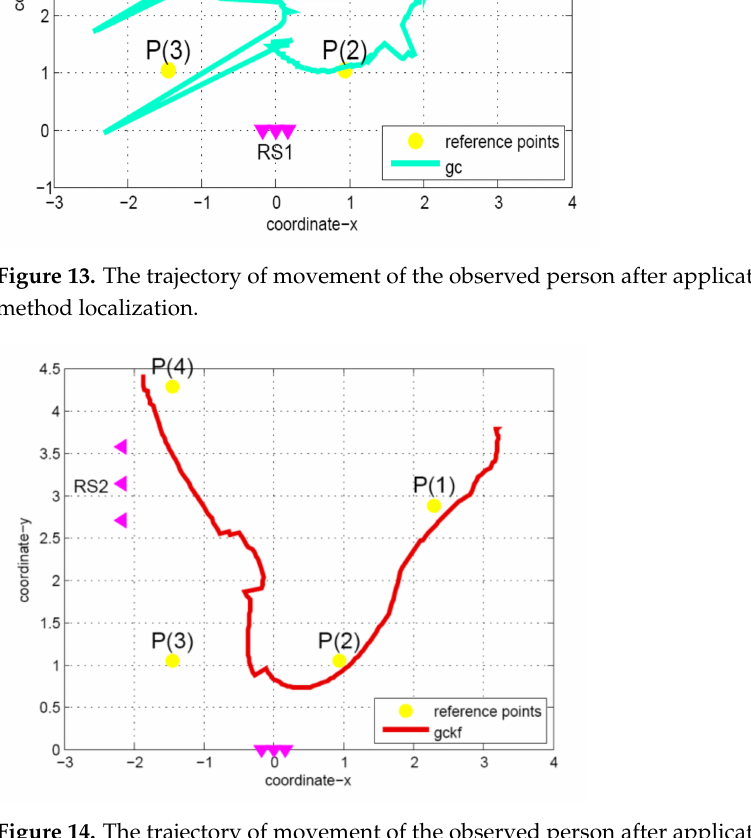
Figure 14. The trajectory of movement of the observed person after application of the straight-line method localization and linear Kalman